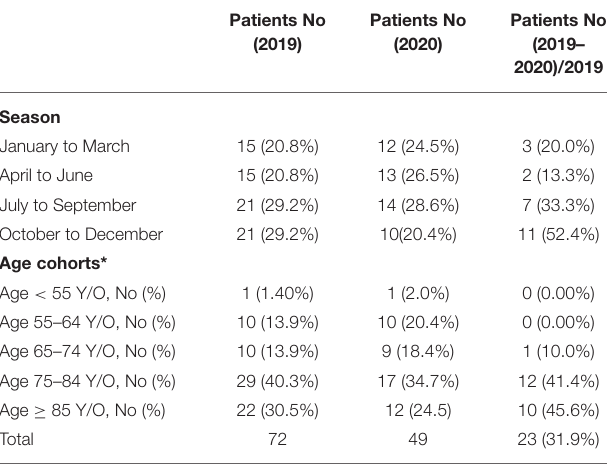
TABLE 3 | Hospital-acquired pneumonia patients requiring hospitalization, by season and age cohorts.